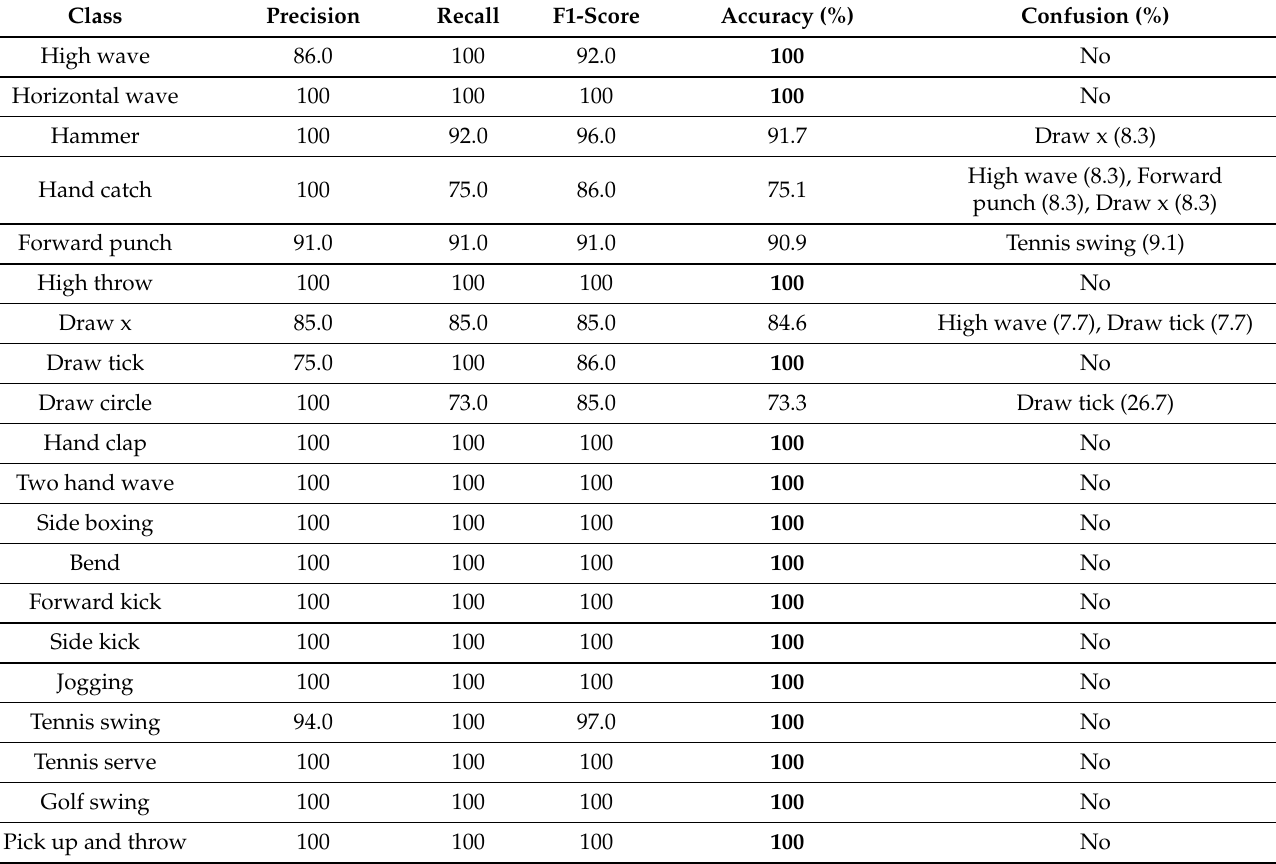
Table 2. Class-specific classification report on MSRAction3D test